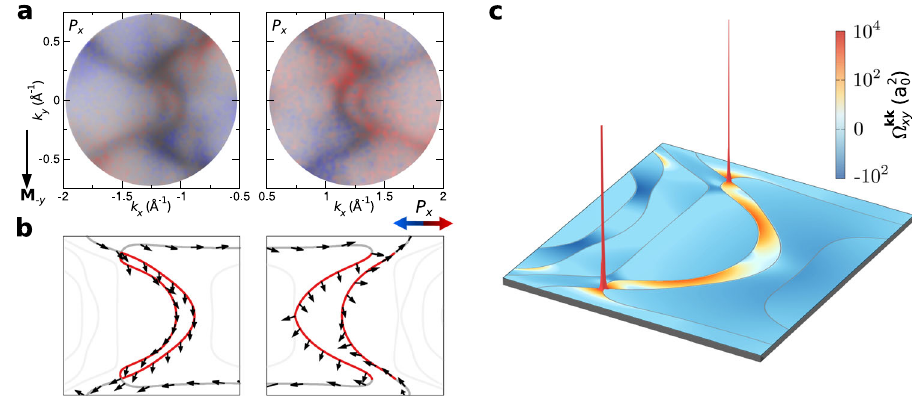
Fig.4|SpintextureandBerrycurvatureoftheFermiarcsinthe2Dtopological ferromagnet. a Measured spin-resolved Fermi arcs in 2 MLs Fe/W(110) on the left and on the right side of the momentum map. Colours indicate the in-plane spin componentalongthe x direction,whichisorthogonaltothesamplemagnetization M − y . The spin polarization P x is indicated by red and blue colours, and the colour strength encodes the intensity. b Arrows denote the complete theoretical spin